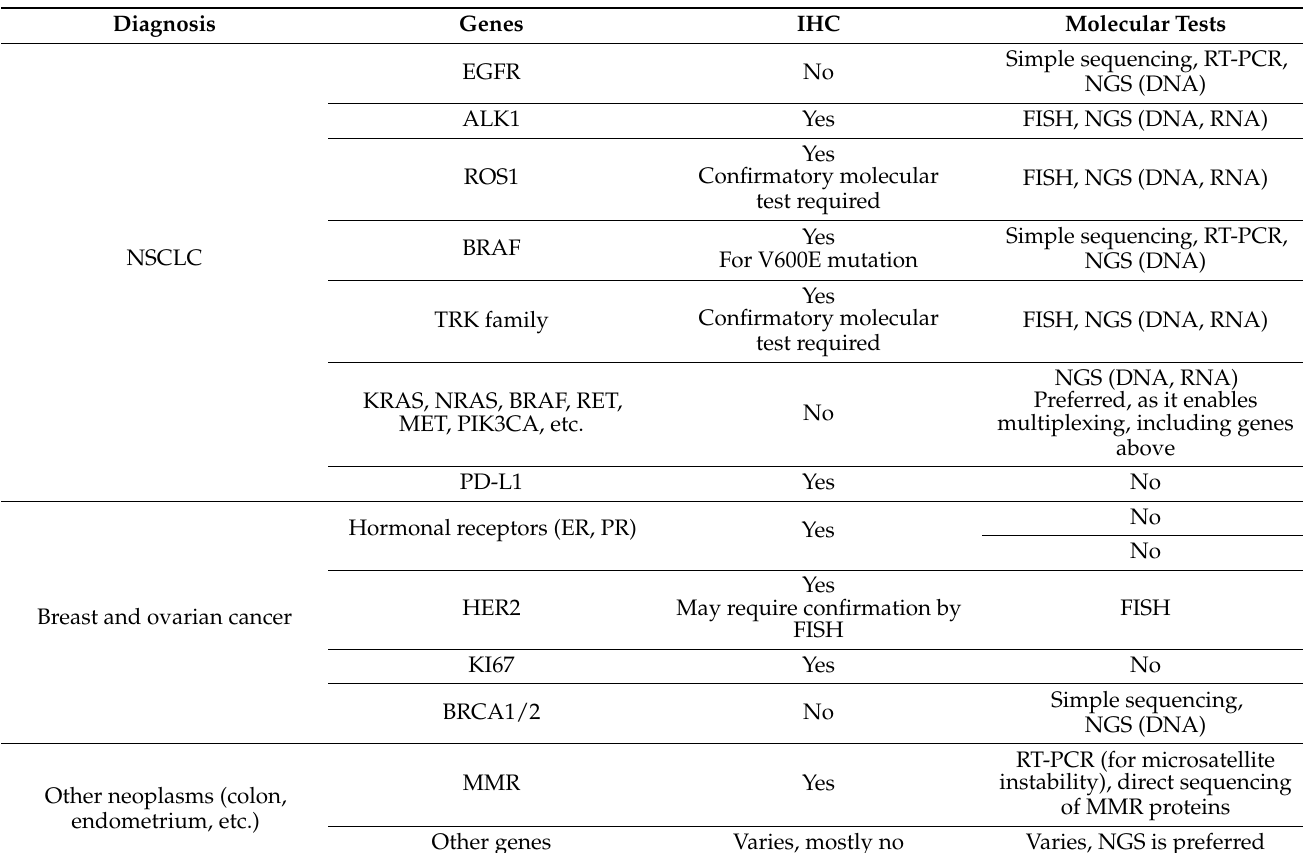
Table 2. Ancillary tests for use in theranostic purposes in the most common neoplasms involving serous cavities *.